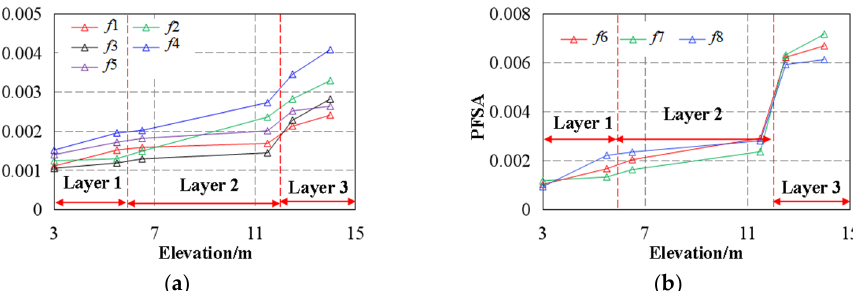
Figure 14. Change of the PFSA in Model 2 when inputting the WE wave in the x direction at different natural frequencies: ( a ) f 1 – f 5 and ( b ) f 6 – f 8 .